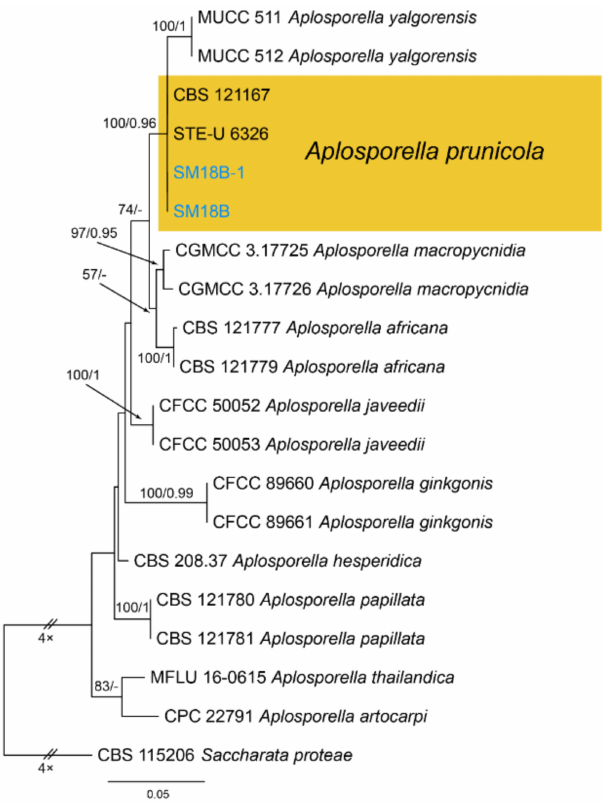
Figure A1. Phylogram generated from RAxML analysis based on combined ITS and tef1 sequence data of Aplosporella isolates. The tree was rooted to Saccharata proteae (CBS 115206). The scale bar indicates 0.05 nucleotide changes per site. Isolates from this study are marked in blue, and the identified species is marked in